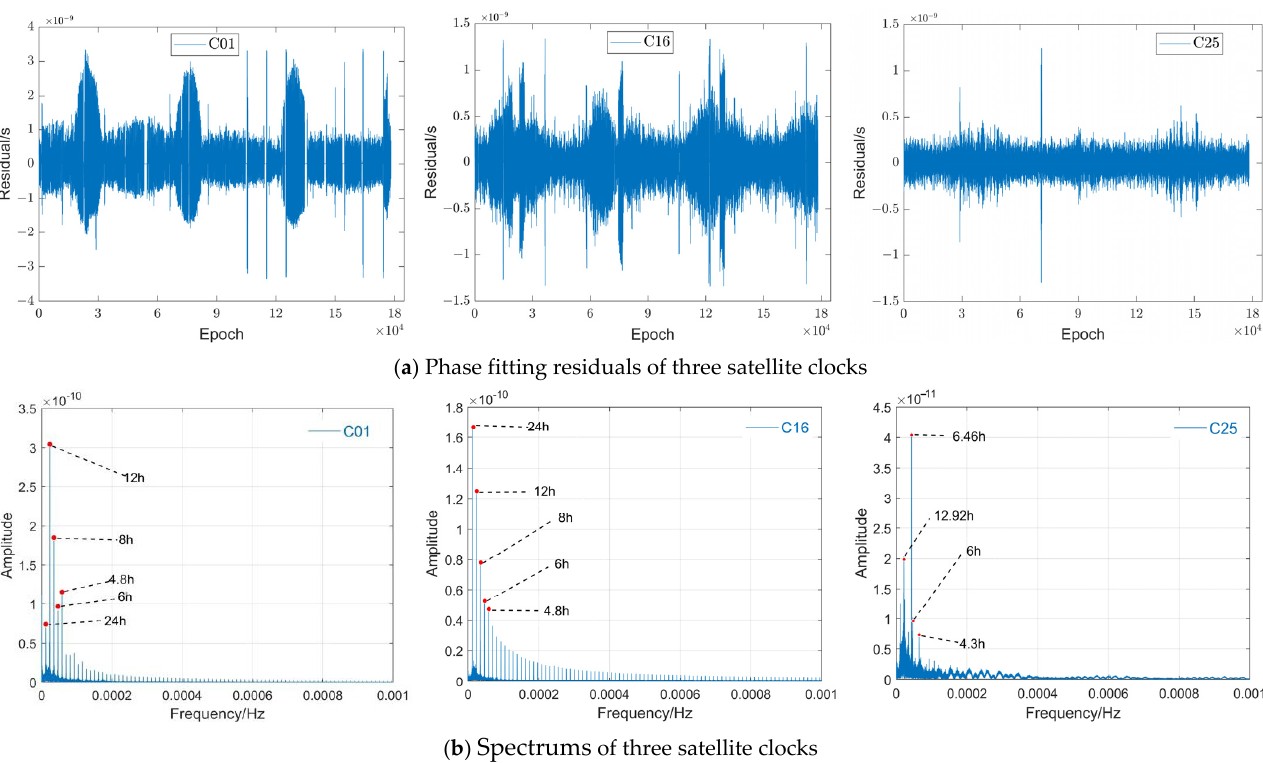
Figure 6. Residuals and spectrums of different satellite clocks.